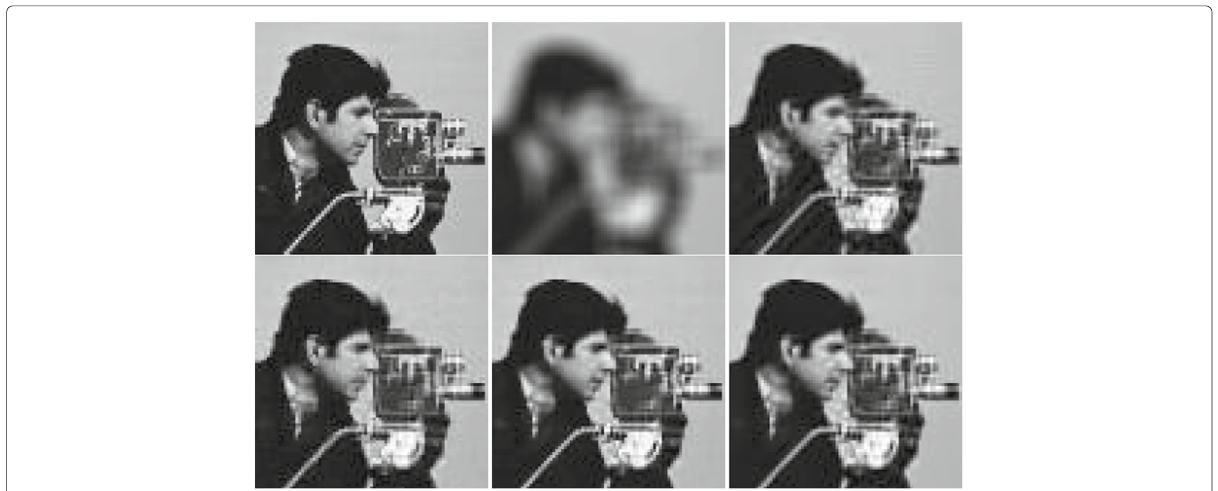
Fig. 1 Deblurring of Cameraman image, scenario 3. From left to right and from top to bottom are presented zoomed fragments of the following images: original , blurred , and noisy , reconstructed by BM3DDEB, L0-Abs, IDD-BM3D, and our method. In our method, the two input parameters used, (σ , s ) , are ( 7.5,550 ) for this scenario, ( 7.5,85 ) for scenario 1, ( 7.5,25 ) for scenario 2, ( 7.5,10 ) for scenario 4, ( 7.5,50 ) for scenario 5, and ( 7.5,5 )